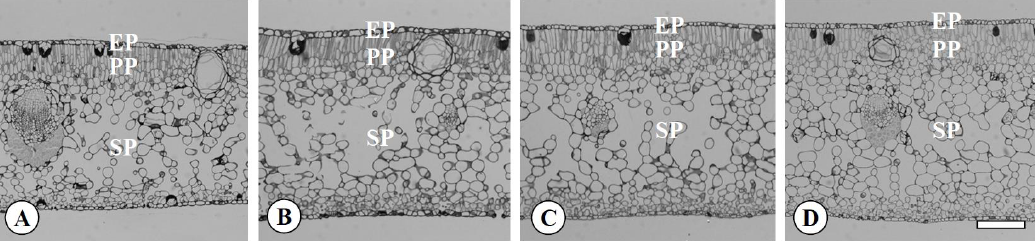
Figure 2. Comparison of the morphological characteristics of leaves ( A , bar = 5 cm), flowers ( B , bar = 1 cm), and fruits ( C , bar = 3 cm) in the diploid, the tetraploid, the Yubeni, and the chimera of the Meiwa kumquat.